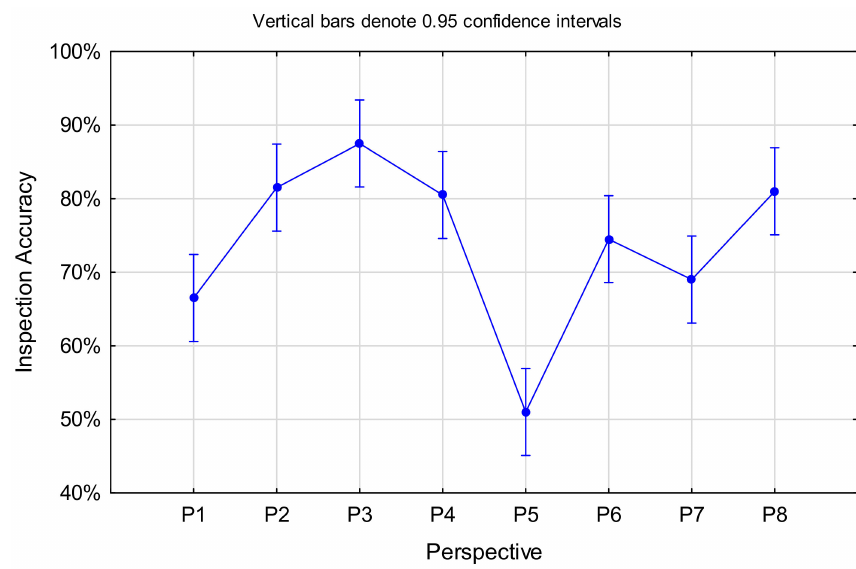
Figure 12. Effect of blade perspective on inspection accuracy.